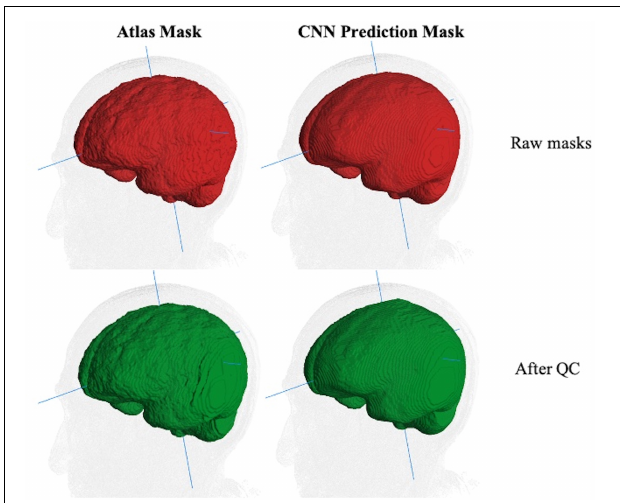
FIGURE 3 | Comparison of ICC mask quality before and after human QC. The same MRI image with an atlas-based GT (left column) and CNN prediction mask (right). Top row (red): raw masks before QC. Bottom row (green): masks after human QC. The edge-based variability is a source of random noise in ground truth. Less variability is introduced for human QC of CNN predictions than for atlas-based